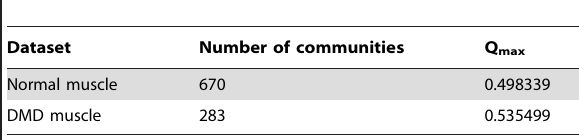
Table 4. Communities from the GSE6011